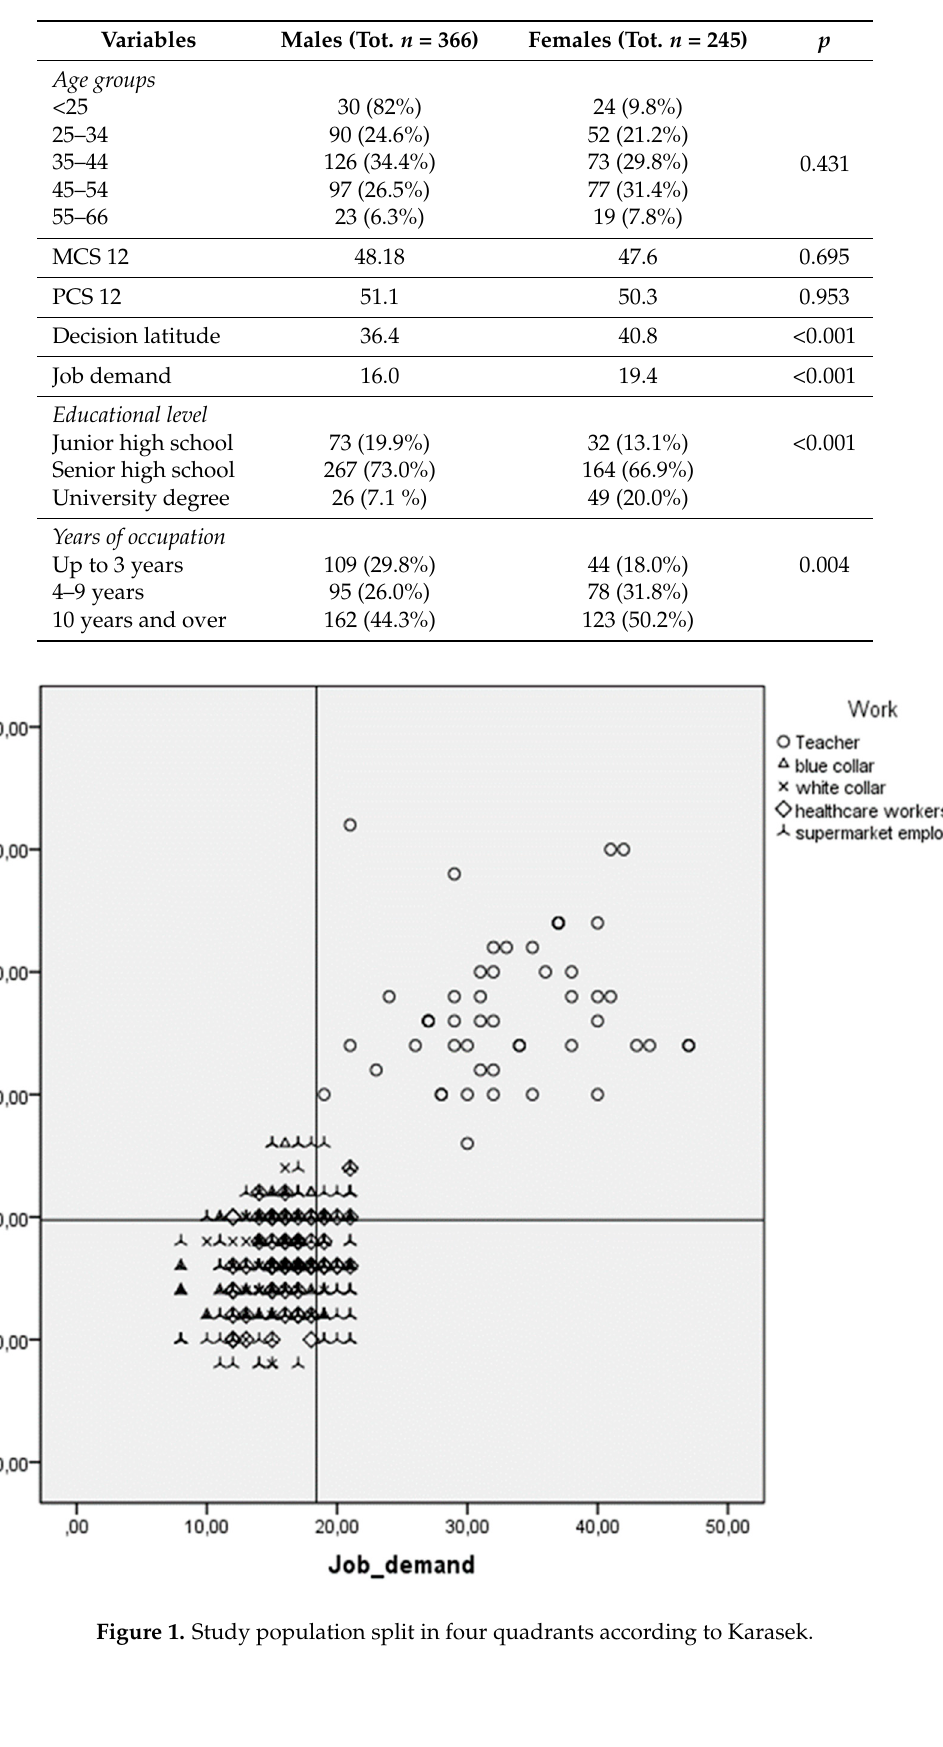
Table 1. Characteristics of the sample population by gender.